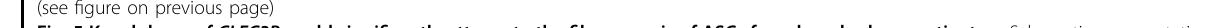
Table S10), for example, CEBPB , FOSL2 , STAT1 , and IRF7 for the pro-in fl ammatory macrophage subpopulation c8.